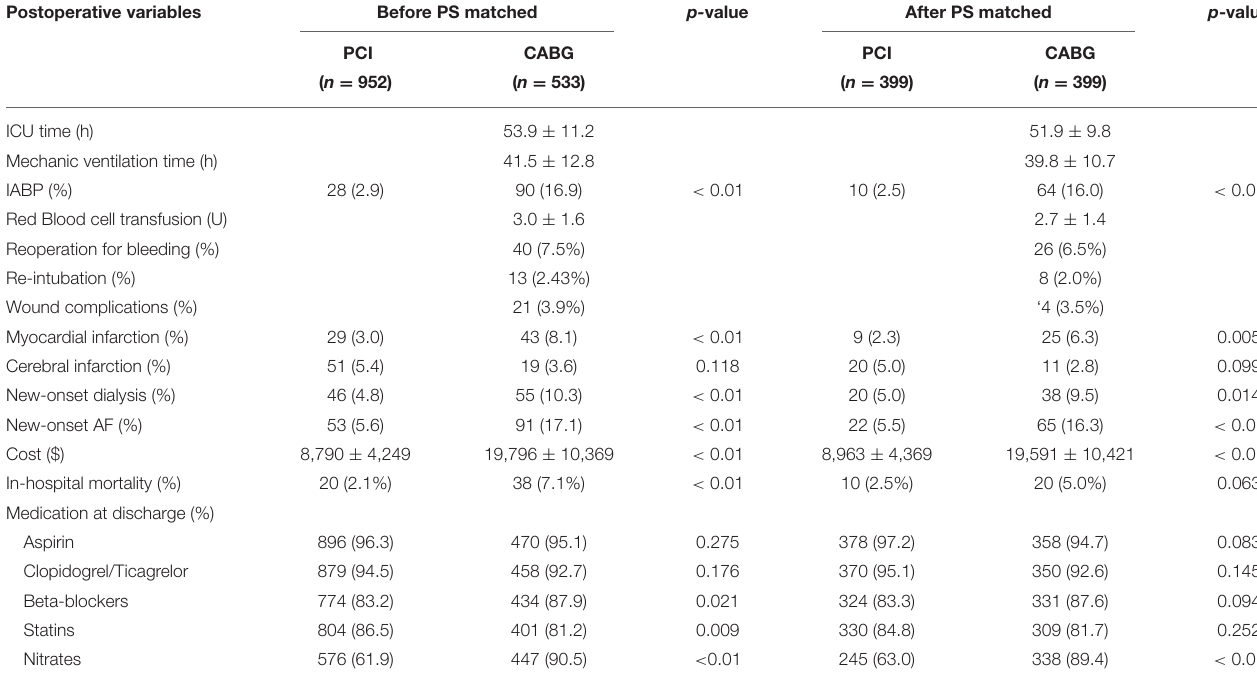
TABLE 2 | Comparison of postoperative data between CABG and PCI groups. Postoperative